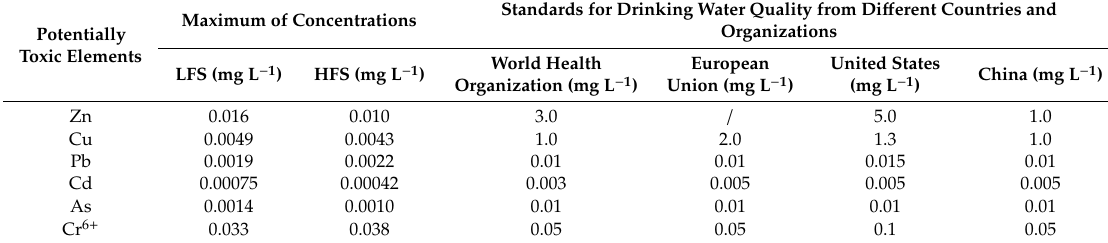
Table 1. Comparison of the measured toxic elements concentration and different world standards for drinking water quality.